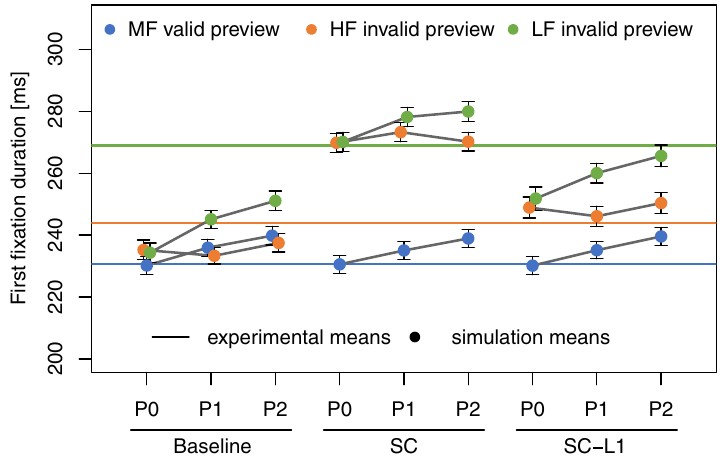
Figure 3. Model comparison of n + 1 fixation durations as a function of three preview conditions. Horizontal lines reflect the empirical condition means using the same color legend. P0: Foveal inhibition only. P1: Foveal and parafoveal inhibition. P2: Foveal and delayed parafoveal inhibition. Baseline: Simple processing reset after display change. SC: Additional saccade cancelation. SC-L1: Saccade cancelation during lexical processing (L1) only.